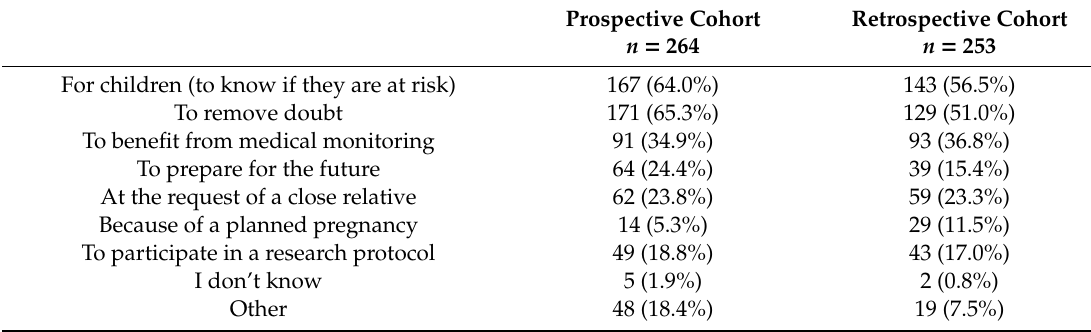
Table 2. Reasons for undergoing predictive genetic testing. (Multiple answers were